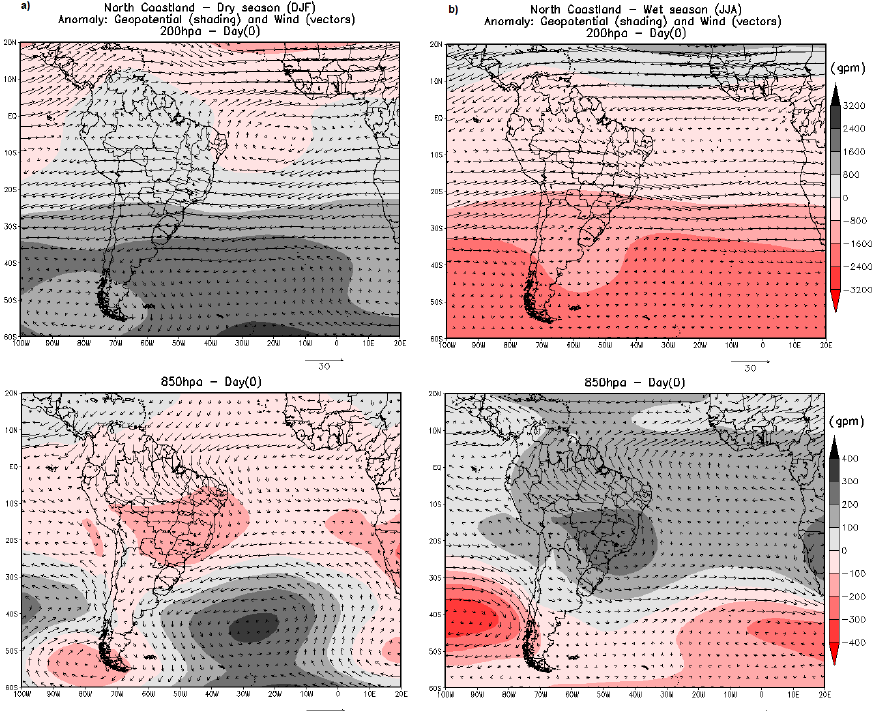
Fig. 3. Geopotential anomaly (shading) and wind anomaly (vectors) at 200hPa and 850hPa for the north coastland: (a) dry season and (b) wet season.